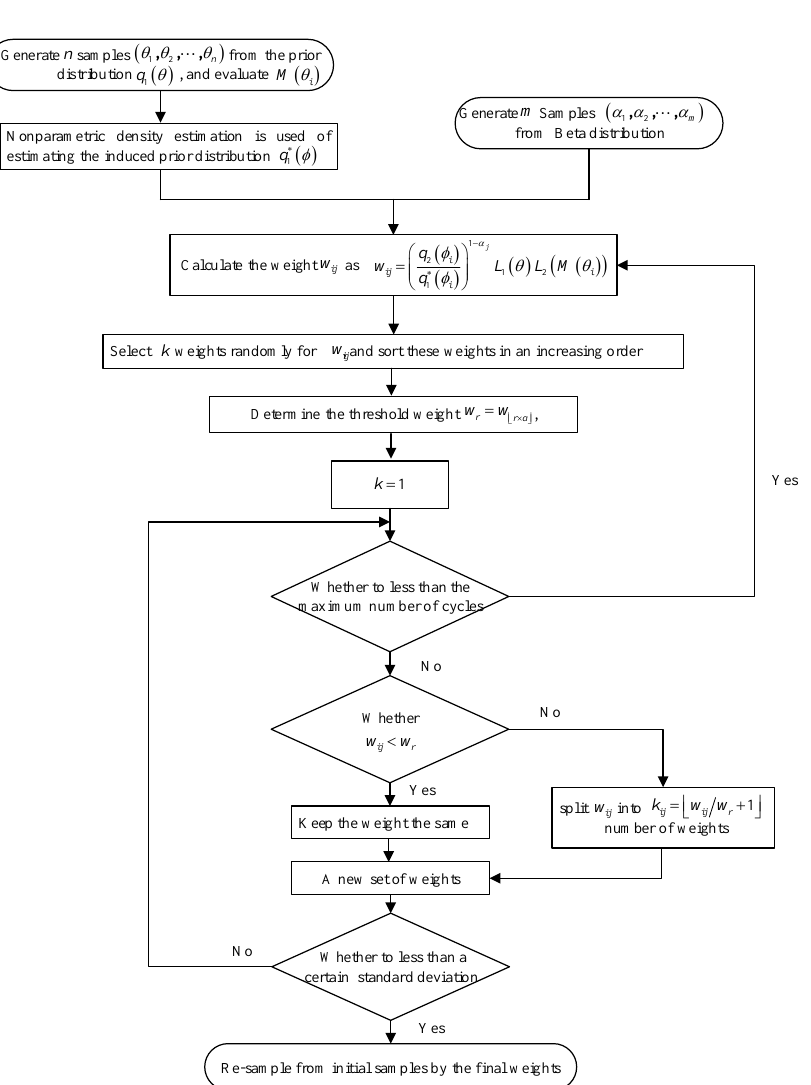
Figure 1. The process of inferring a posterior based on the adaptive Bayesian melding (ABM)